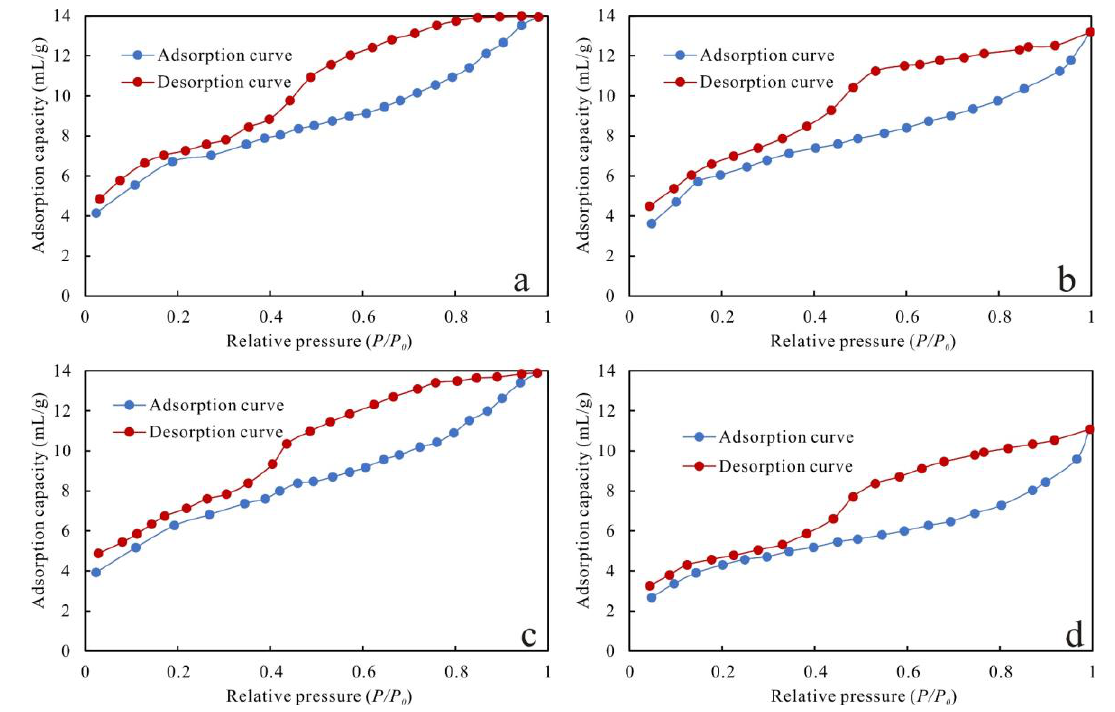
Figure 13. N2 adsorption/desorption isotherms of shale of S 1 l 1 − 1 member. ( a ). 2393.55 m, N3, S 1 l 1 − 1a ; ( b ). 2385.15 m, N3, S 1 l 1 − 1b ; ( c ). 2380.11 m, N3, S 1 l 1 − 1c ; ( d ). 2371.35 m, N3, S 1 l 1 − 1d .